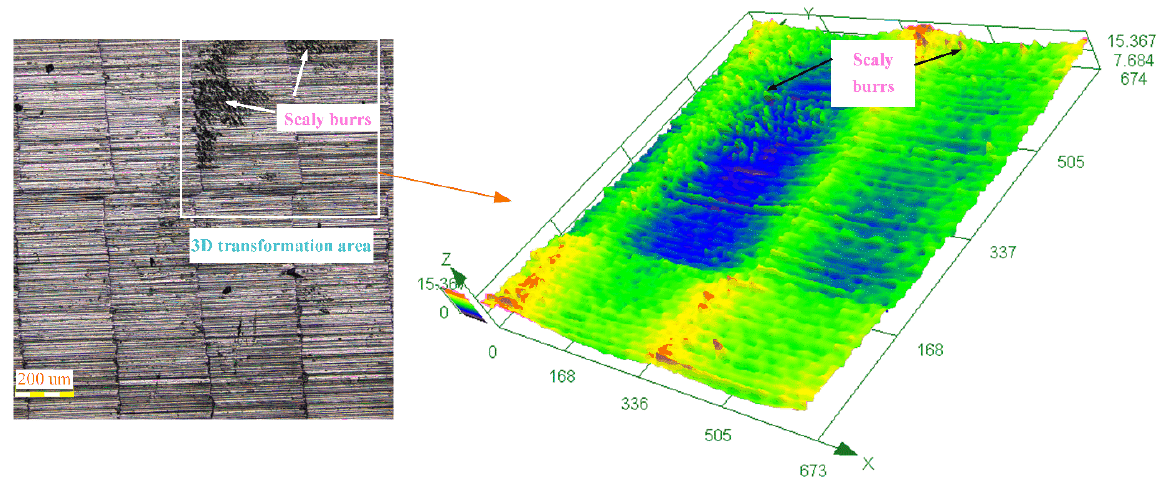
Figure 6. Scaly burrs of the milled surface.